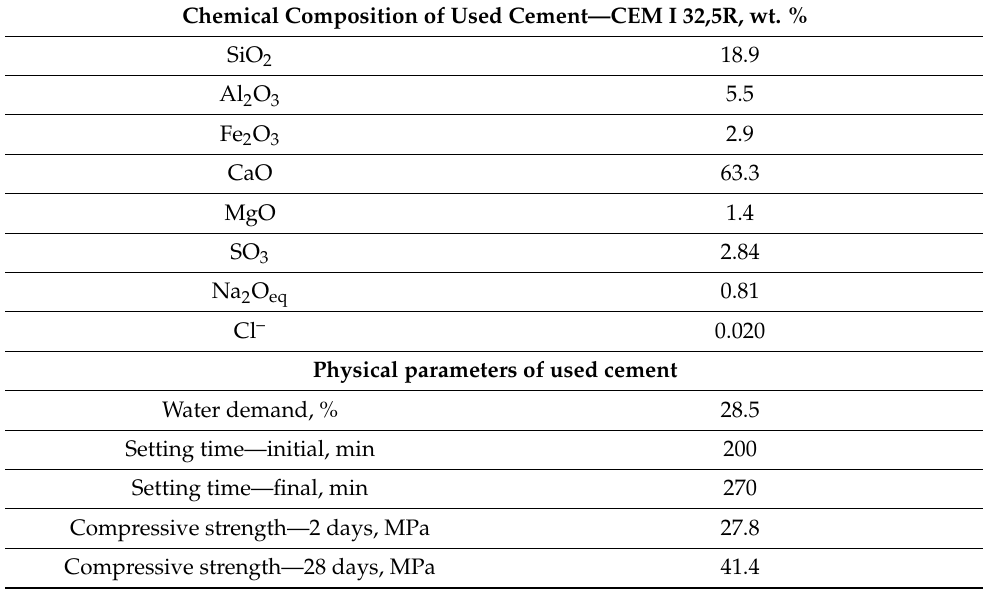
specific procedures for different types of components) and physical